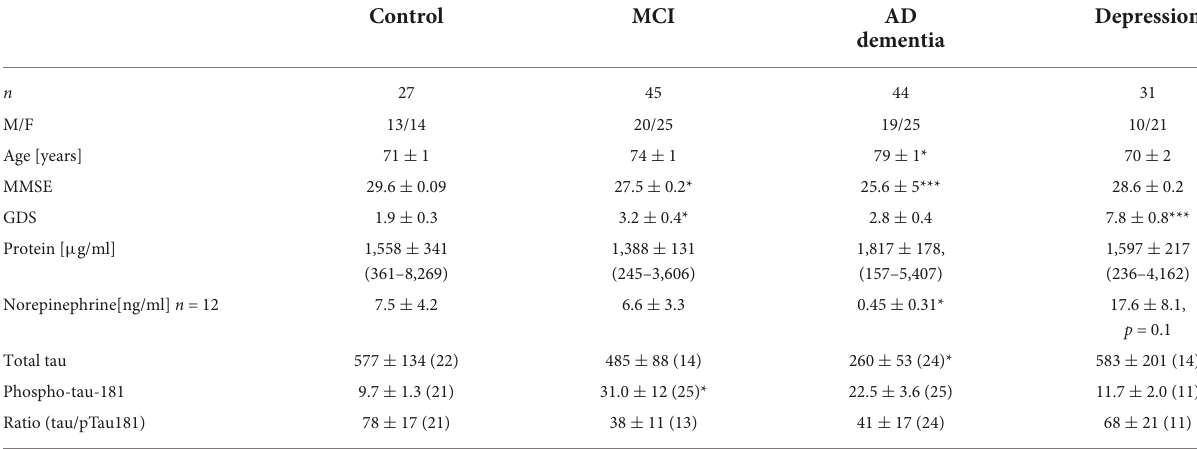
TABLE 1 Demographic data and biomarkers in saliva.